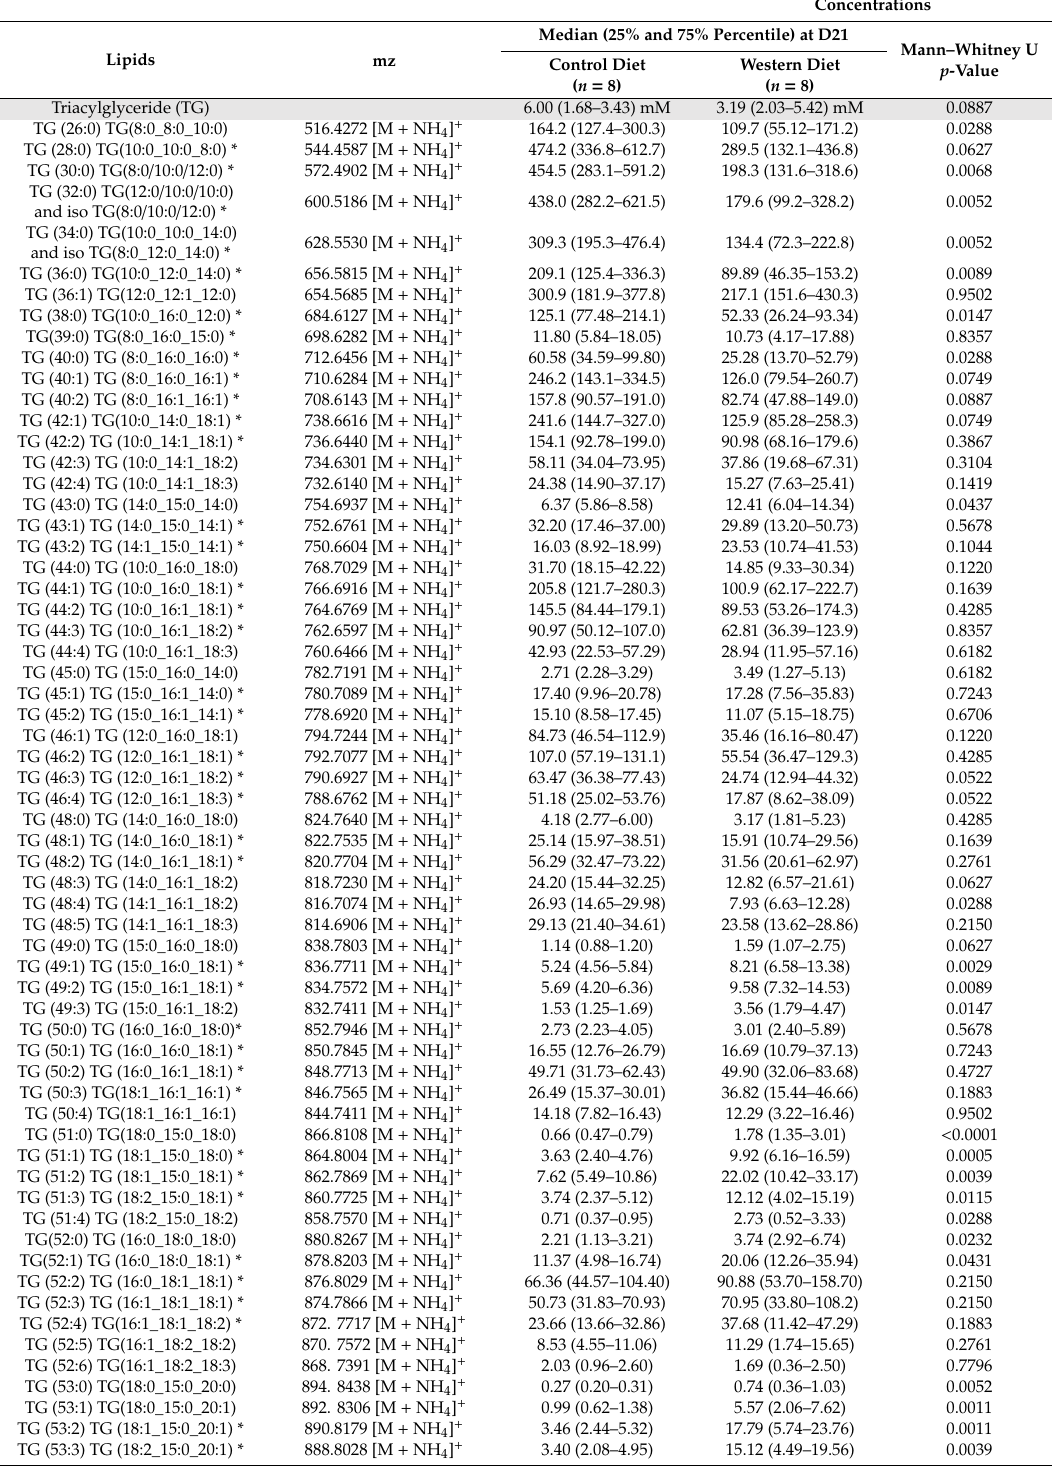
Table 2. Concentrations of annotated lipids that discriminated (* VIP > 1.5 in PLS-DA model (components 1–2)) lipidotypes of breast milk provided by dams fed control or western diet at day 20 of lactation